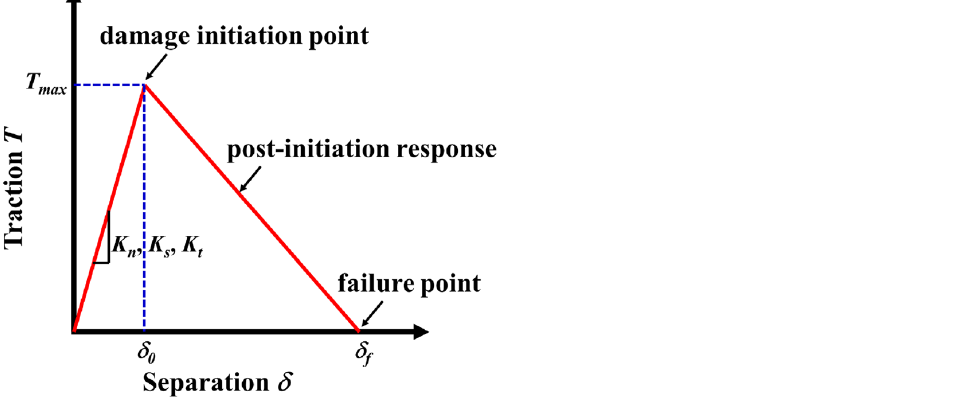
Figure 17. Schematic diagram of triangular